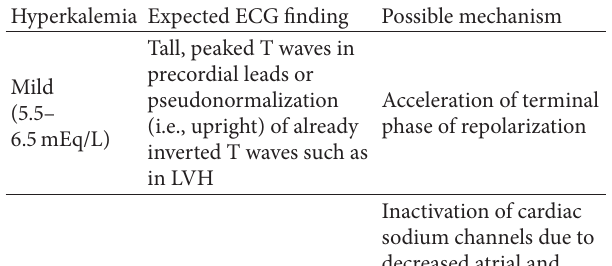
Table 1: ECG changes of hyperkalemia depending upon severity with possible